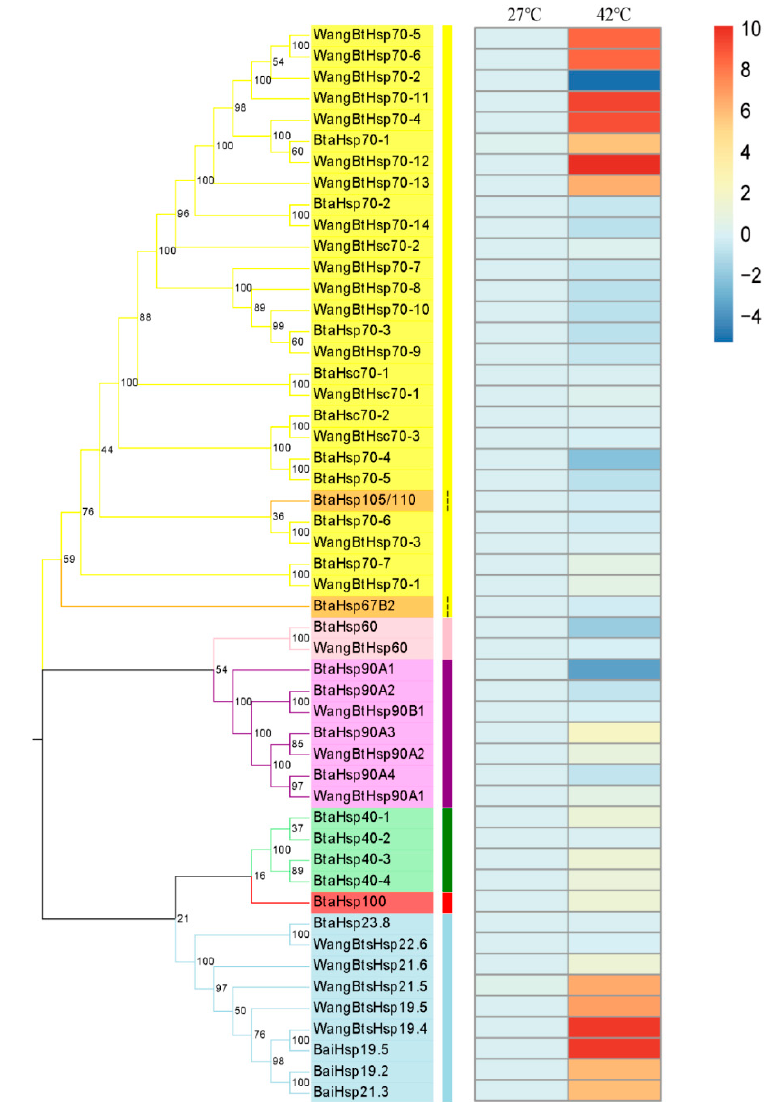
Figure 7. Phylogenetic relationships and gene expression under 42 ◦ C treatment for 3.5 h of the Bemisia tabaci HSP (BtaHSP) gene superfamily. The unrooted phylogenetic tree was constructed using MEGA7 by the neighbor-joining method and the bootstrap test was set as 1000 replicates. The colored shadow represents the different HSP families. The heatmap showed the RT-qPCR analysis results of HSP genes in B. tabaci subjected to heat stress. The colors of the bar vary from blue to red and represent the scale of relative expression levels. The two columns represent the two processing temperatures, and each row represents one HSP gene member.